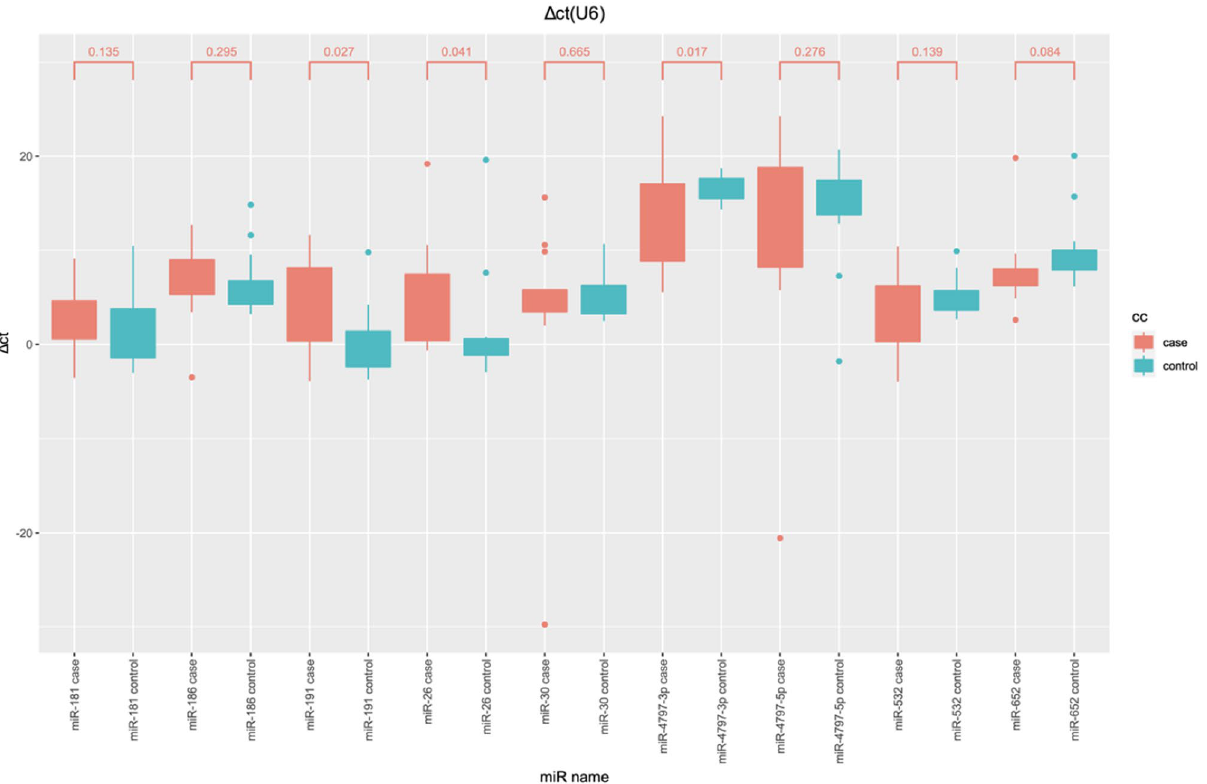
Figure 2. Normalization of miRs cycle threshold using U6 in the box plot. There is significant up-regulation in miR-4797-3p and miR-191 and downregulation in miR-26 in case compare to control in